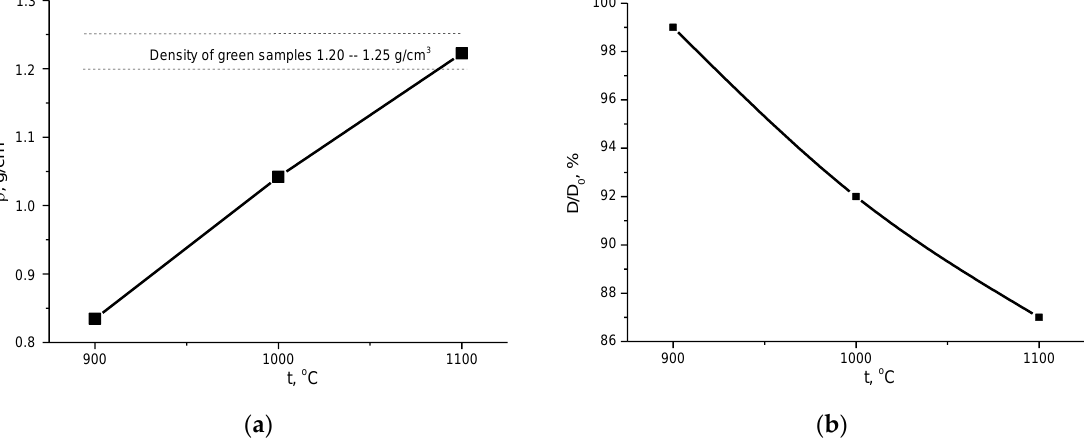
Figure 9. Density ρ , g/cm 3 ( a ), and relative diameter D/D 0 , % ( b ), of ceramic samples prepared from the powder mixture of dicalcium hydrogen phosphates powder (mainly brushite) and calcium citrate tetrahydrate after firing at 900, 1000, 1100 °C.